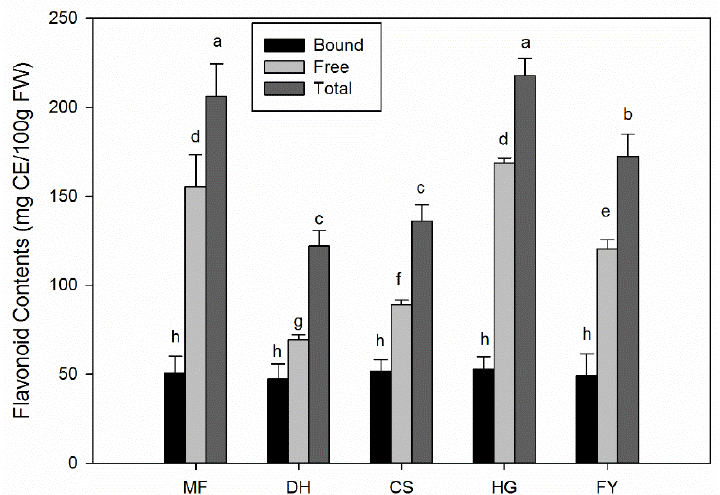
Figure 2. Flavonoid contents of five different chestnut cultivars. Turkey test was carried out in each group (bound, free and total) respectively and significant differences ( p < 0.05) exist among those bars with different letters.